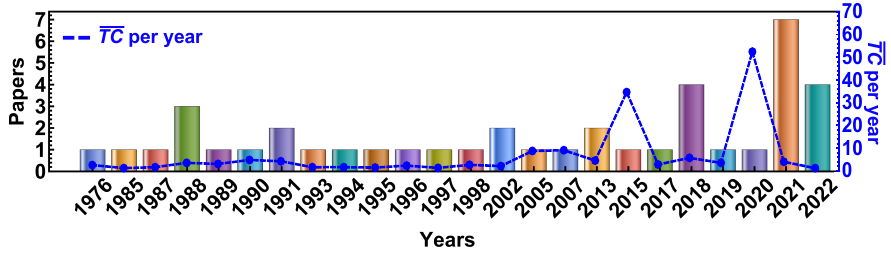
Figure 3. Annual publication trend of selected documents retrieved from Scopus, Pubmed and WOS between 1976 and 2022. A blue dashed line denotes the average TC per